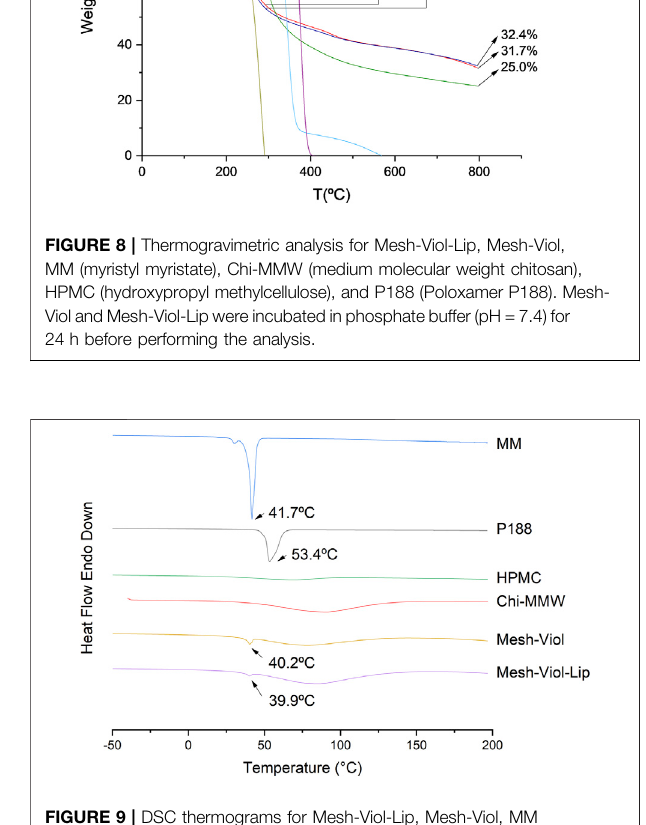
FIGURE 9 | DSC thermograms for Mesh-Viol-Lip, Mesh-Viol, MM (myristyl myristate), Chi-MMW (medium molecular weight chitosan), HPMC (hydroxypropyl methylcellulose), and P188 (Poloxamer P188). Mesh-Viol and Mesh-Viol-Lip were incubated in phosphate buffer (pH = 7.4) for 24 h before performing the analysis. Y-axis represents heat fl ow (exothermic is